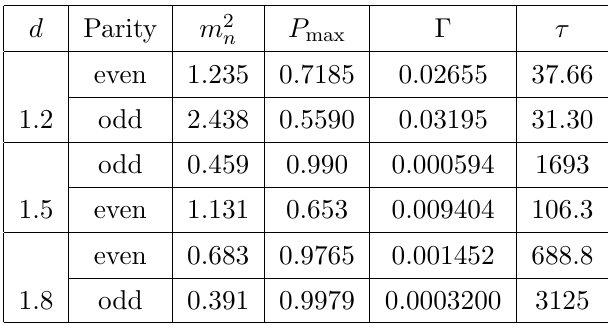
Table 5. The mass spectrum m 2 , relative probability P max , FWHM (cid:0) and life-time (cid:28) of a part of n the resonances quasi-localized between the sub-branes with di(cid:11)erent brane distance for the double brane model (3.8).